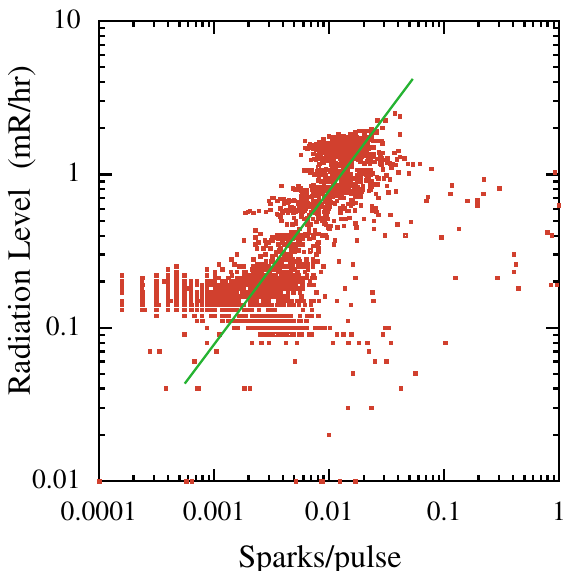
FIG. 32. (Color) Fermilab linac data on the correlation between the sparking rate and the ambient radiation level in the linac enclosure, an indirect measure of dark currents. These data were accumulated over many months.